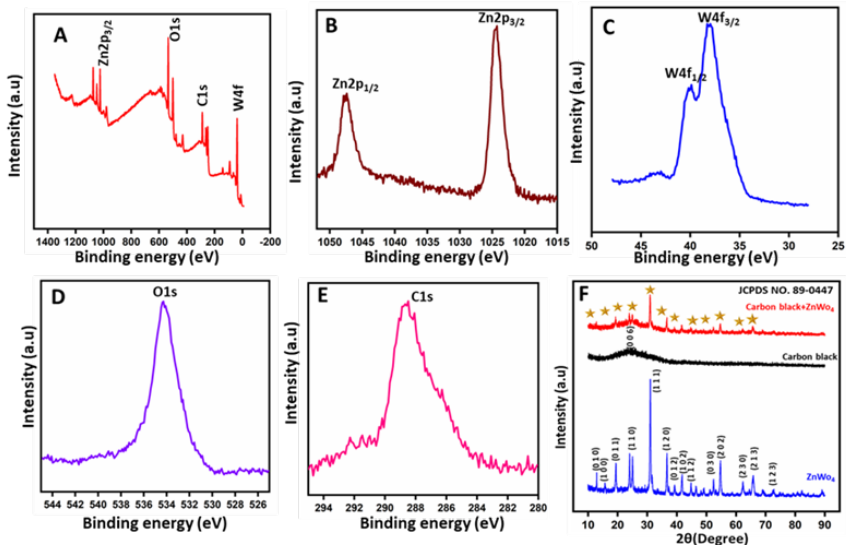
Figure 4. ( A ) XPS survey spectrum of ZnWO 4 /CB; ( B ) Zn 2p; ( C ) W 4f; ( D ) O 1s; ( E ) C 1s; and ( F ) XRD pattern of CB, ZnWO 4 , ZnWO 4 /CB composite.